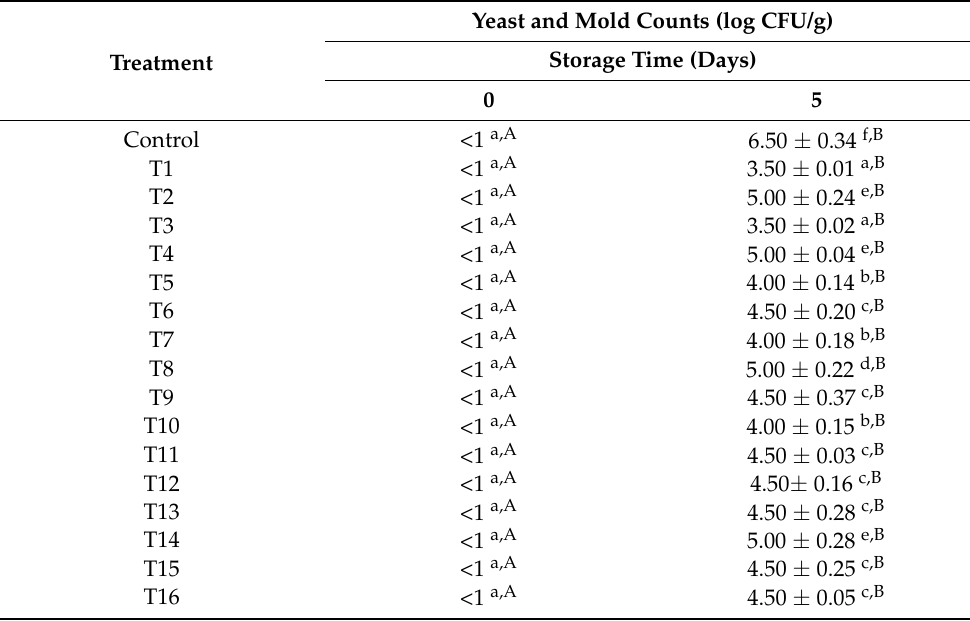
Table 2. Microbiological analysis of pomegranate arils stored under active MAP at ambient temperature 1 .